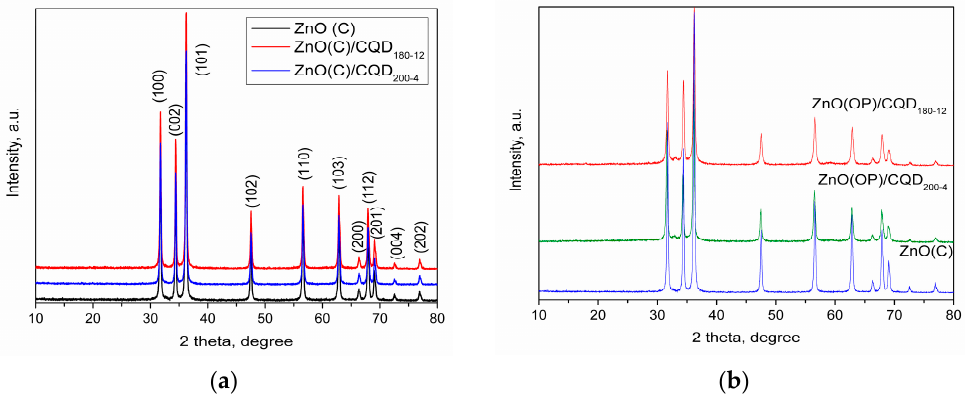
Figure 5. ( a ) The XRD patterns of the ZnO(C)/CQD nanocomposites; ( b ) the XRD patterns of the ZnO(OP)/CQD nanocomposites.